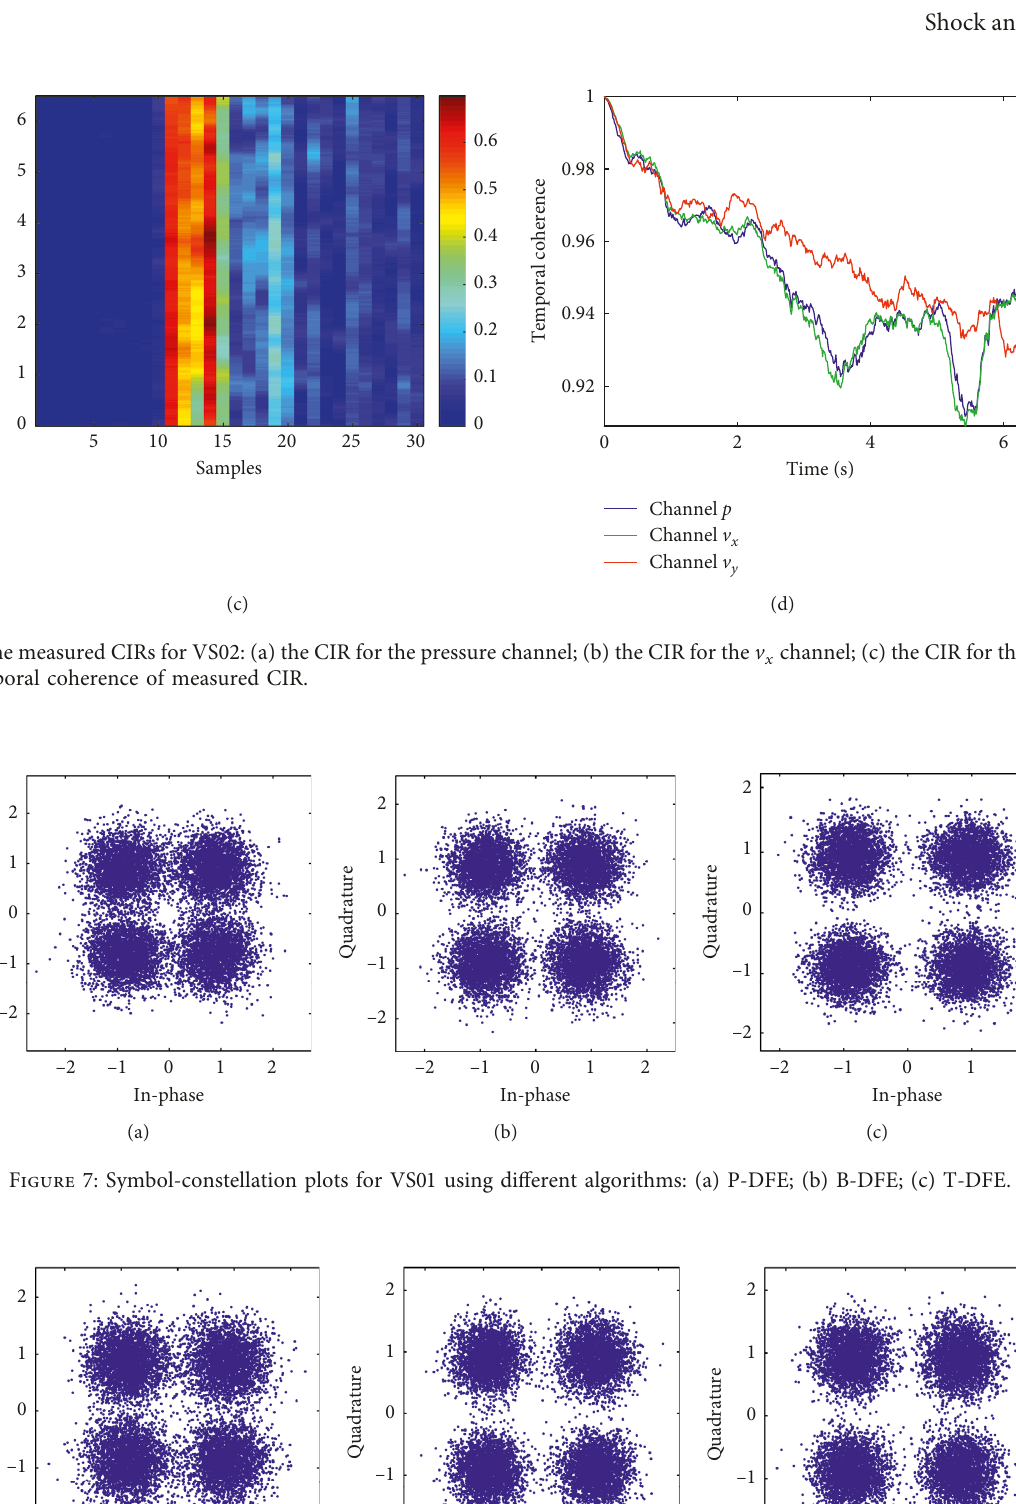
Figure 8: Symbol-constellation plots for VS02 using different algorithms: (a) P-DFE; (b) B-DFE; (c)